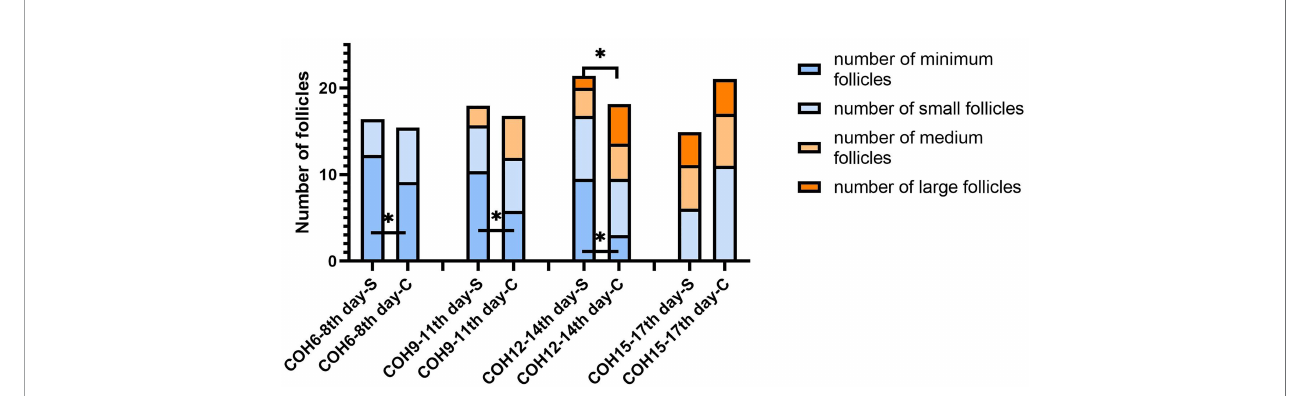
FIGURE 6 | Changes in the number of follicles of different sizes during the COH process in the antagonist group patient (note: (1) *Indicates statistically signi fi cant difference (P < 0.05); (2) S: SOR group; C: control group; (3) n (SOR group) = 54, n (control group) =